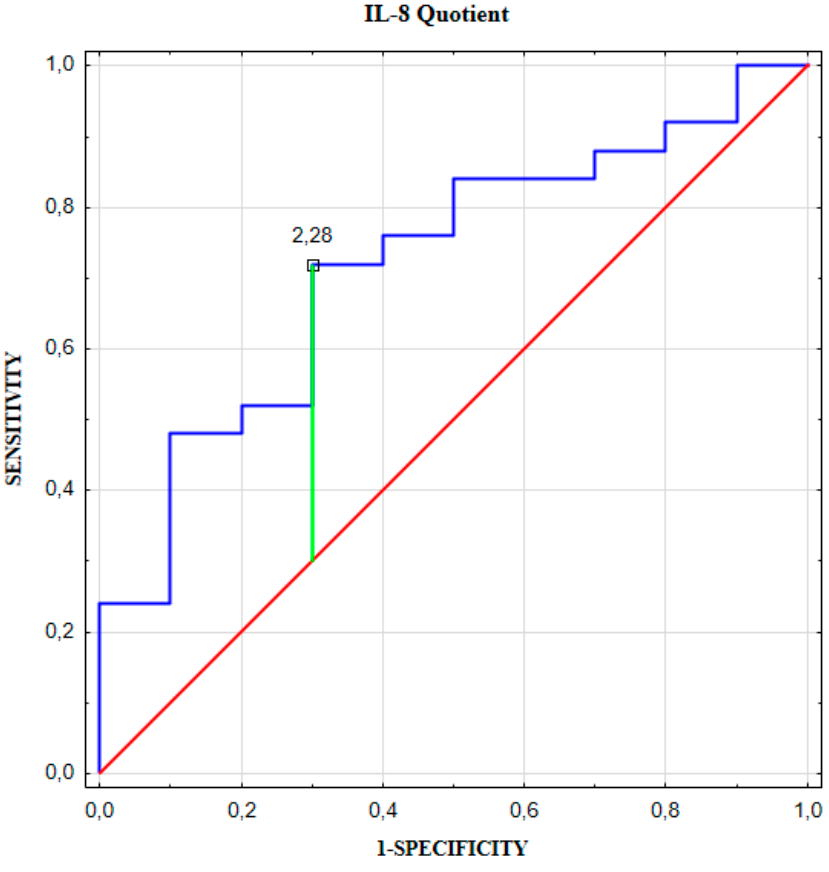
Figure 3. IL-8 Quotient receiver operator characteristic (ROC) curve for differentiating unruptured intracranial aneurysm patients from individuals without brain aneurysm. Table 3. Diagnostic parameters of IL-8 Quotient in di ff erentiating unruptured intracranial aneurysm patients from subjects without intracranial